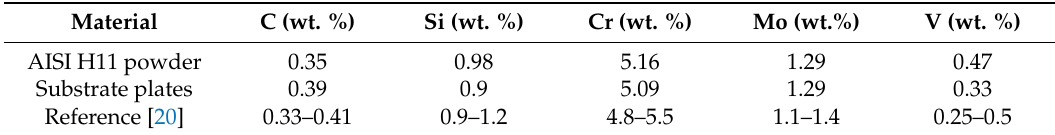
Table 1. Chemical composition of AISI H11 powder and AISI H11